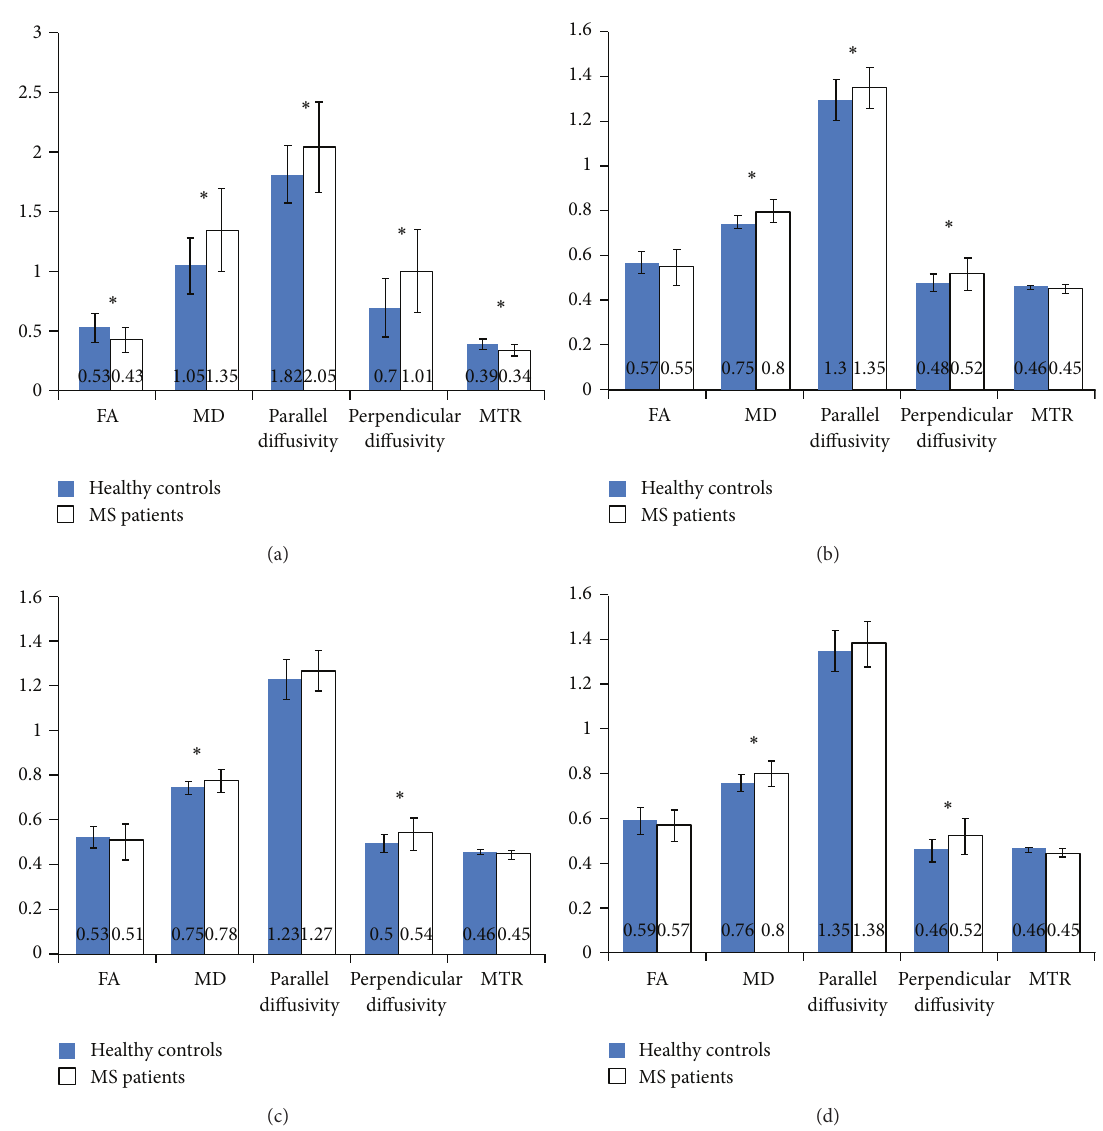
Figure 3: Mean MRI indices in MS cases and healthy volunteers across the fornix (a) and averaged cingula (b), left cingulum (c) and right cingulum (d). ∗ Indicate significant differences (𝑃 ≤ 0.05) between the two groups. FA: fractional anisotropy, MD: mean diffusivity, and MTR: magnetization transfer ratio. Error bars represent the standard deviations of the